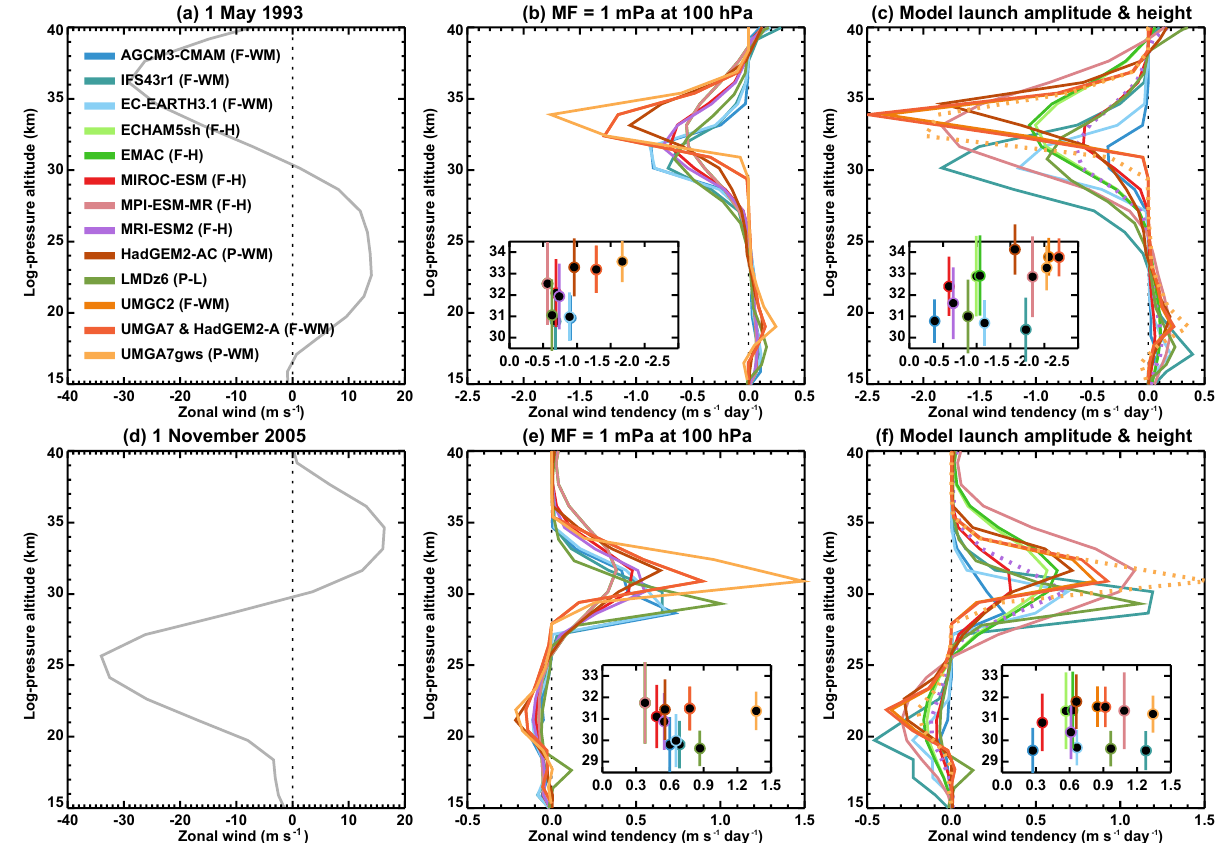
Figure 7. Vertical profiles of zonal mean non-orographic GWD computed using the parameterization schemes used by the different models. The offline calculations are performed using ERA-Interim equatorial zonal and meridional winds and temperatures for 1 May 1993 (a, b, c) and 1 November 2005 (d, e, f) . The middle panels show results for the case in which the momentum flux is set to 1mPa at 100hPa ( ≈ 16km). The right panels show results for the case in which the models’ own launch amplitudes and launch heights are used. Note that the results in the right-hand panel for MRI-ESM2 and UMGA7gws have been multiplied by 0.1 and 0.6, respectively, and the GWD profiles plotted using dotted lines (see Appendix B). The labels in parentheses to the right of the model names denote the type of GWD scheme: “F” or “P” for fixed or parameterized sources; “H” for Hines, “WM” for Warner–McIntyre, or “L” for Lott et al. (2012) for the type of dissipation used. Note that “WM” here includes both the Warner and McIntyre (1999) and Scinocca (2003) schemes (Table 8), which are both implementations of the Warner and McIntyre (1996) framework for gravity wave parameterization. The insets show the parameters of Gaussian fits, A exp [− ((z − B)/C) 2 ] , to the zonal mean GWD profiles. The peaks of the Gaussians ( A , ms − 1 per day, horizontal axes) and their heights ( B , km, vertical axes) are denoted by the filled circles. The e -folding widths of the Gaussians ( C , km) are given by the vertical bars. See text and Appendix B for more